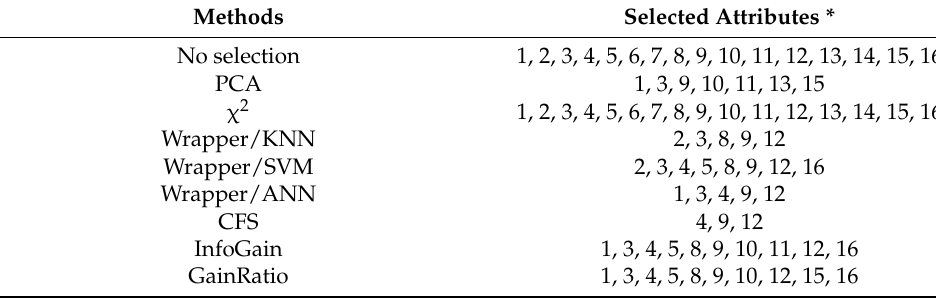
Table 9. Comparison attributes selected by different methods.